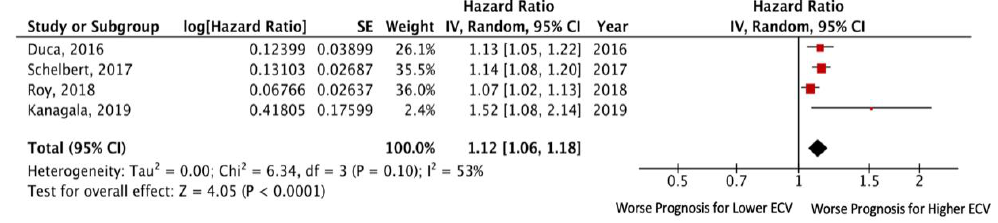
Figure 2. Forest plots comparing outcomes with lower and higher ECV in HFpEF patients.